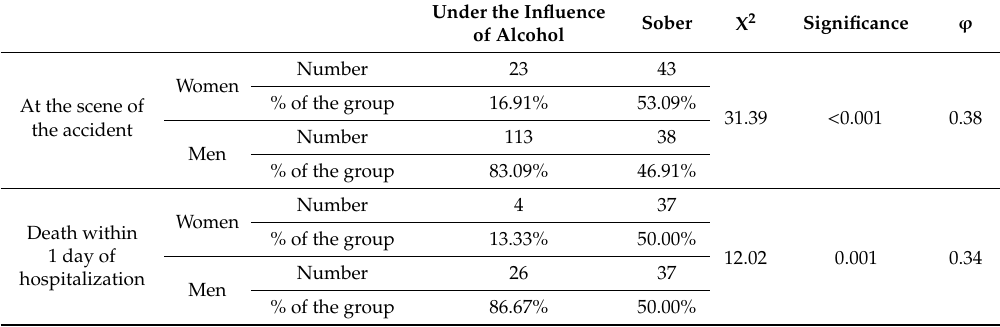
Table 5. Number of victims by group, gender, and location of death.